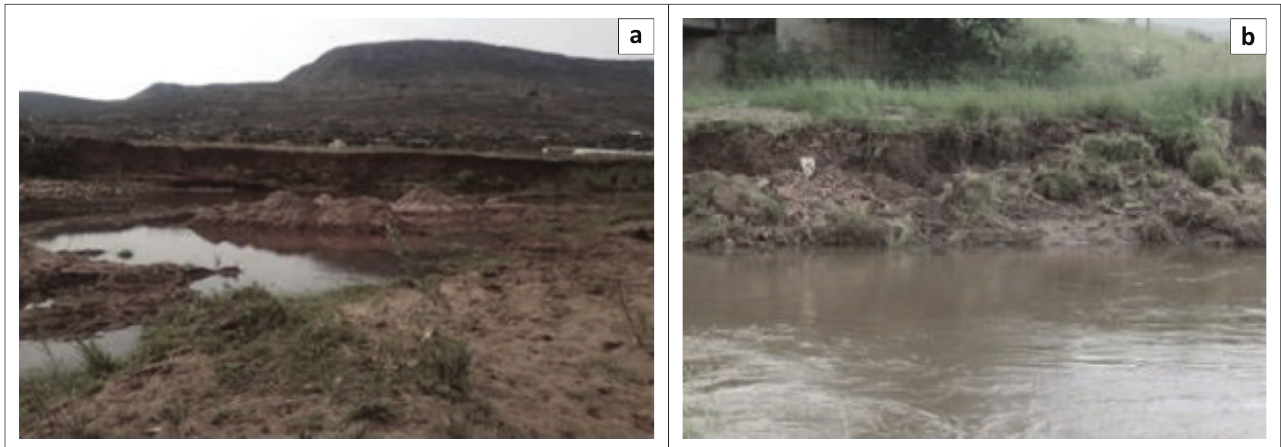
FIGURE 4: Evidence of (a) erosion at selected (b) reaches along the Njelele